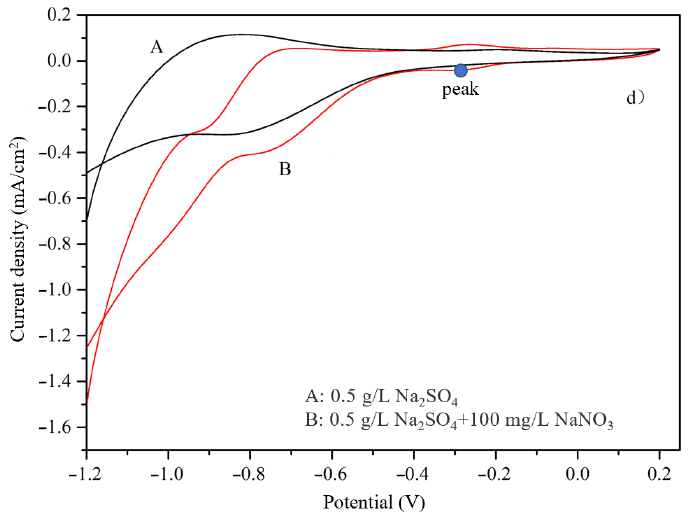
Figure 5. Cyclic voltammograms for ( a ) Ti, ( b ) Ti-nano, ( c ) Cu-TiO 2 , and ( d ) Zn-Cu-TiO 2 electrodes.